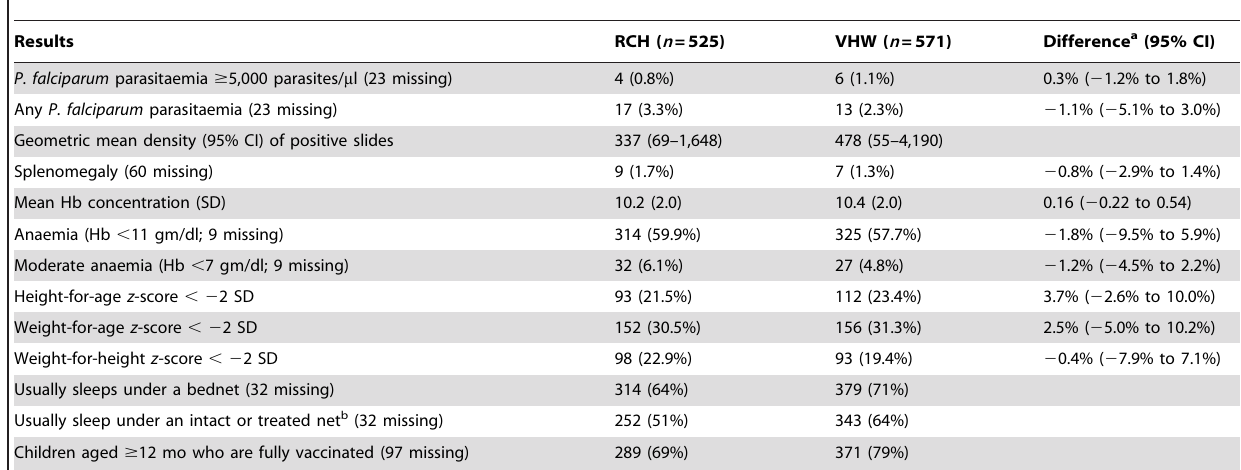
Table 4. Results of end of rainy season cross-sectional survey.